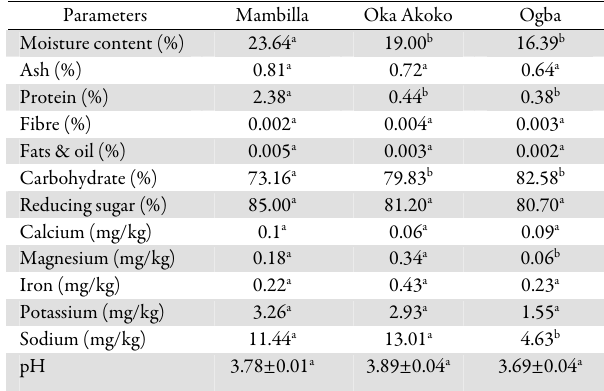
Table 3. Proximate composition, mineral contents and pH of honey